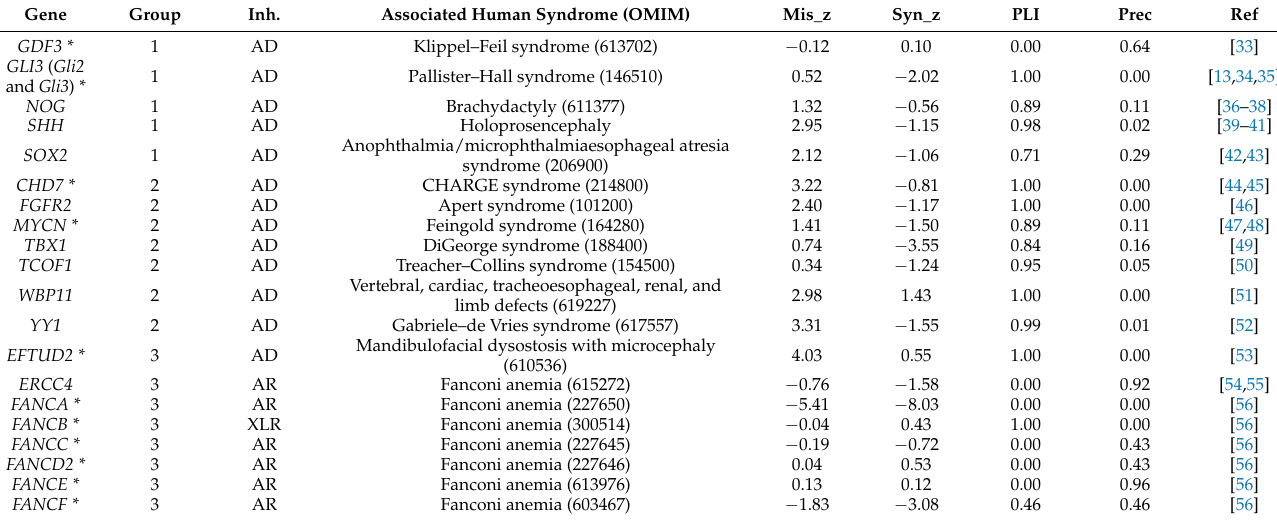
Table 1. Human disease and animal candidate genes modified after [24,25]. * evaluated with Molecular Inversion Probe Screening [32], NA = Not available. Missense and synonymous variation z-scores (Mis_z and Syn_z), probability of intolerance to heterozygous loss of function variation (pLI), or recessive variation (pRec) are derived from the GnomAD database version 2.1.1 (lof_metrics.by_gene) table (https://gnomad.broadinstitute.org/,accessed on 2